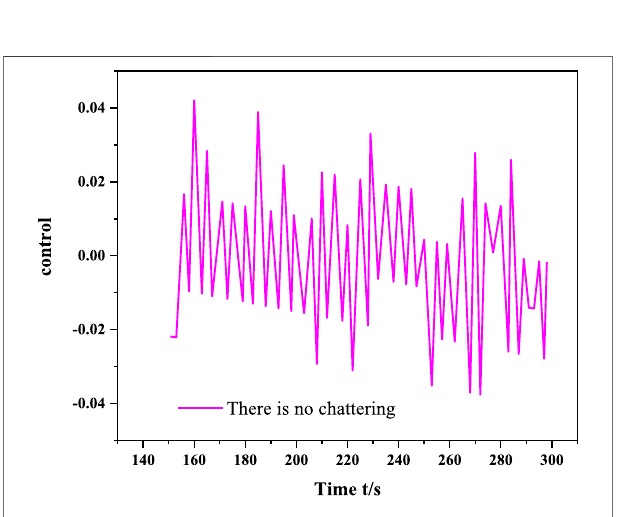
FIGURE 3 | Sliding mode control with target trajectory r = 1.2.